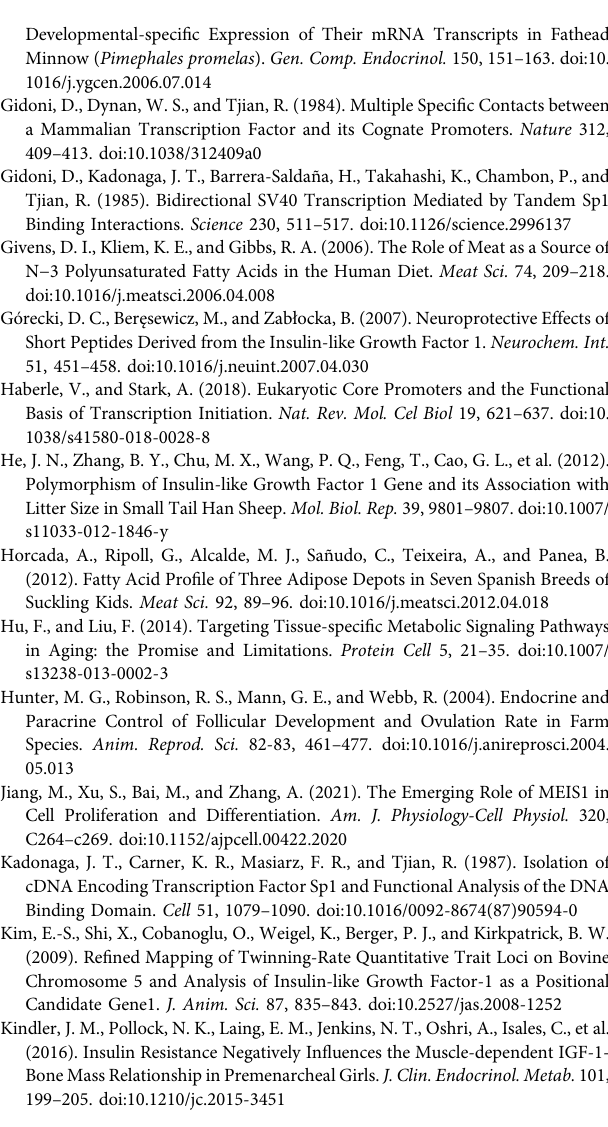
Supplementary Figure S1 | KASP typing results of IGF1 . Blue represents the TT genotype, green representsthe TC genotype, and red represents the CC genotype. Supplementary Figure S2 | Transcription factor prediction results. Supplementary Table S1 | Transcription factor SP1 interferes with the shRNA sequence. Supplementary Table S2 | EMSA probe